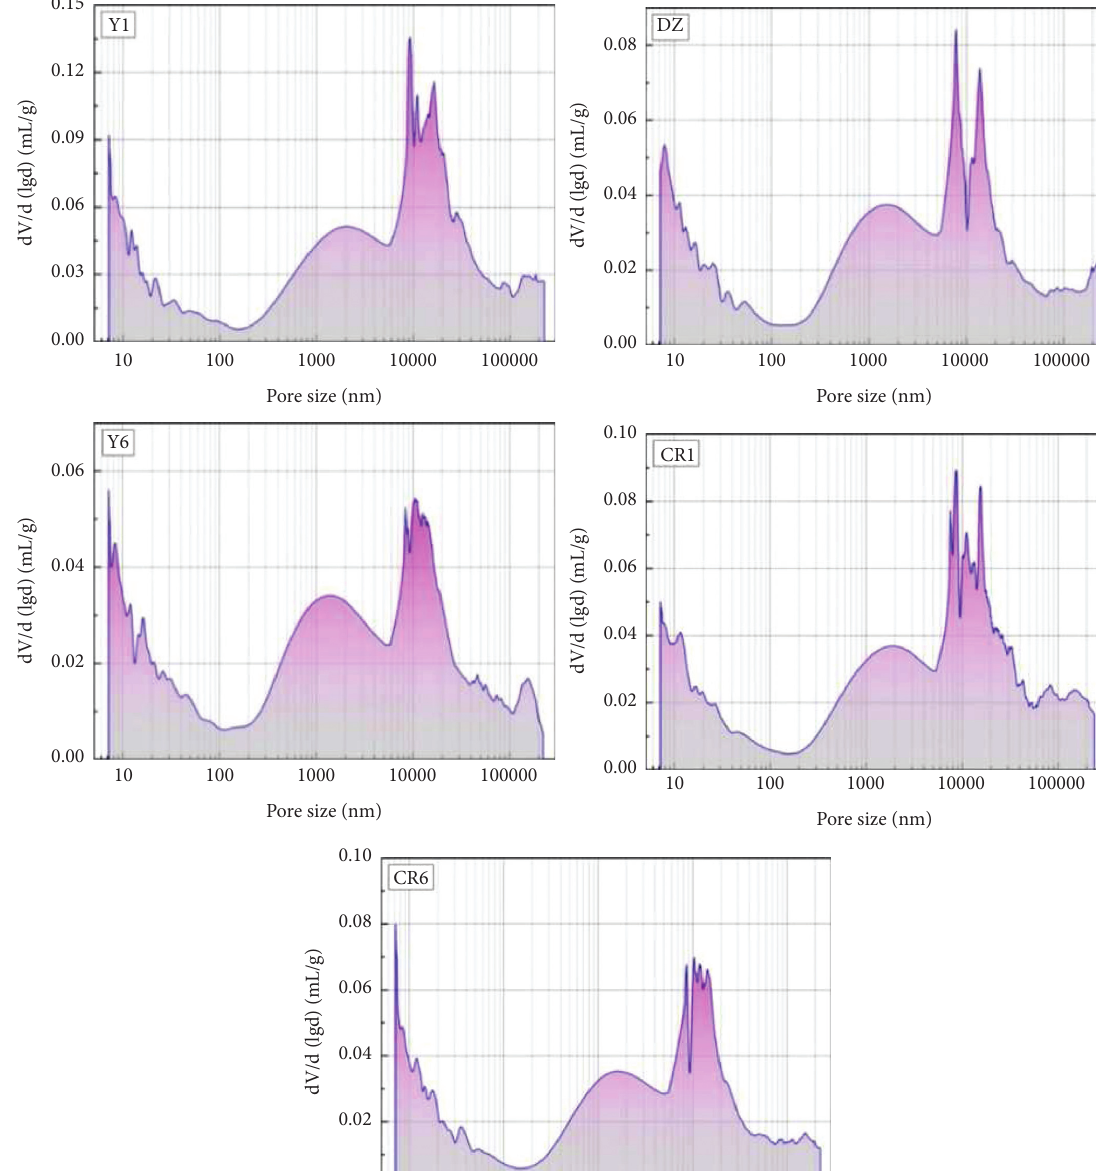
Figure 20: Differential curve of pore size